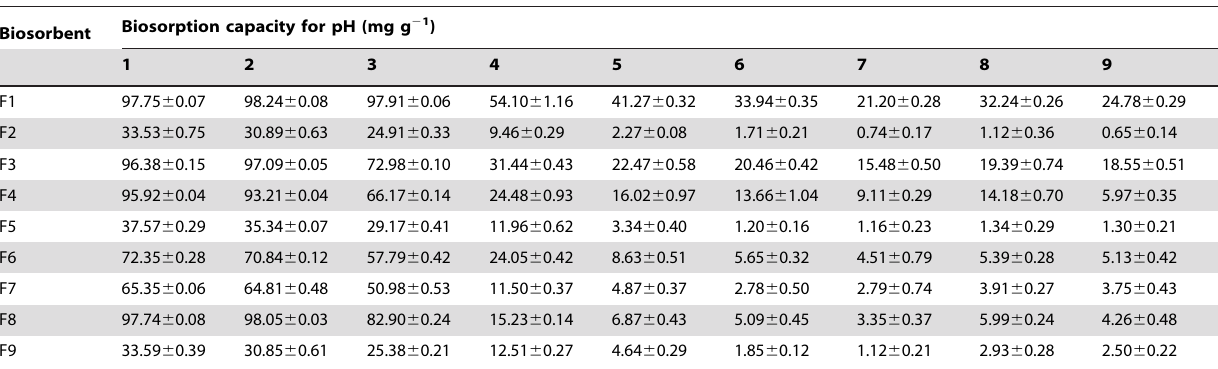
Table 1. The effect of pH on the biosorption capacities of nine biosorbents for Reactive Black 5.